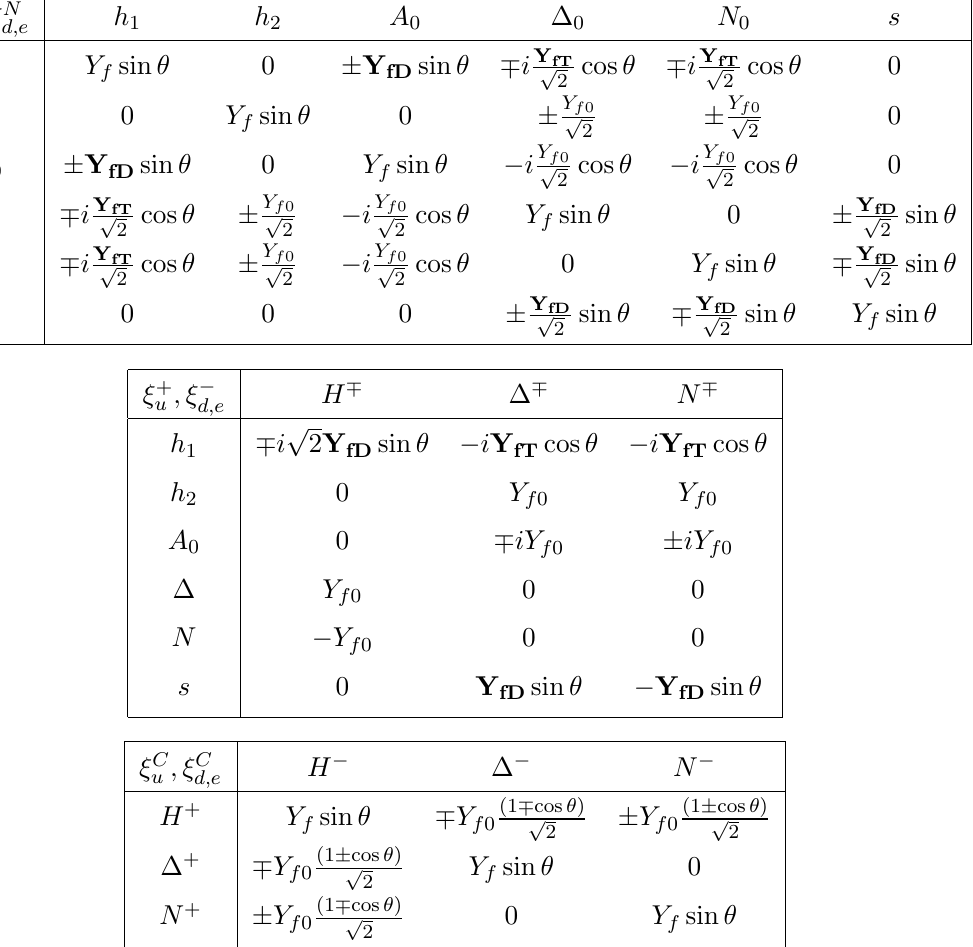
Table 3 . Couplings of two pNGBs to fermions generated by the e(cid:11)ective Yukawas. The (cid:12)rst table lists the couplings of two neutral pNGBs; the second one lists the couplings of one charged and one neutral pNGB; and the third one lists the couplings of two charged pNGBs (the signs refer to up and down/leptons,